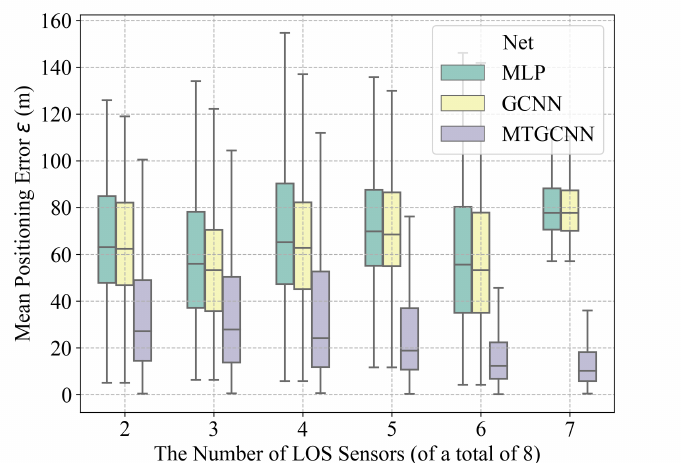
Figure 6. The localization results with a different number of LOS sensors (a total of eight